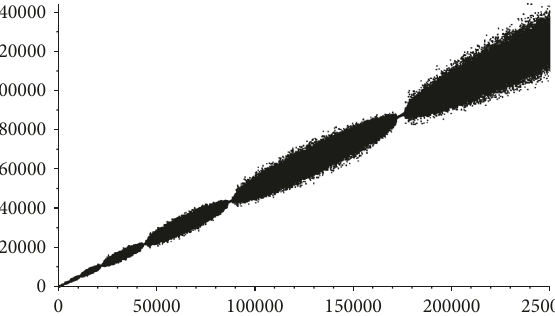
Figure 9: Graph of 𝑄 𝑏 (𝑛) for 1 ≤ 𝑛 ≤ 250000 .